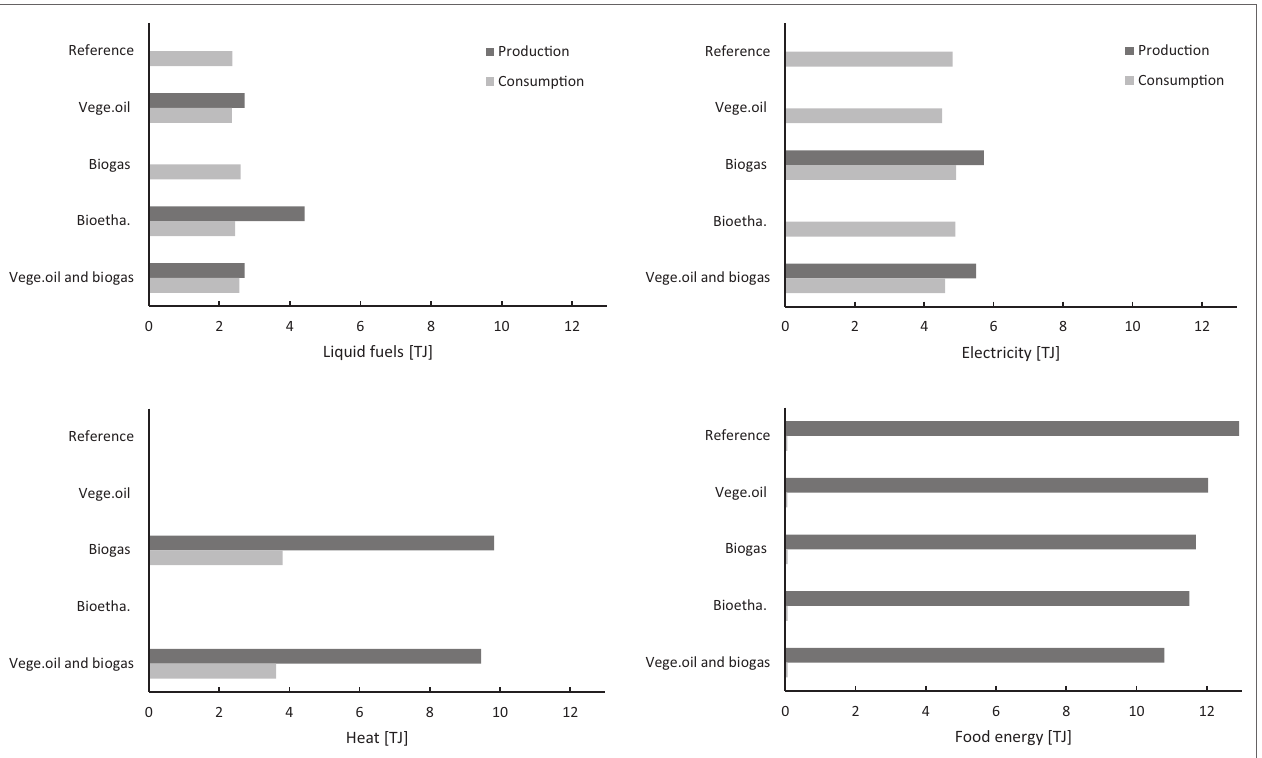
FigUre 3 | annual production and consumption of liquid fuels, electricity, heat, and food energy for the entire system of 1000 ha in each scenario .